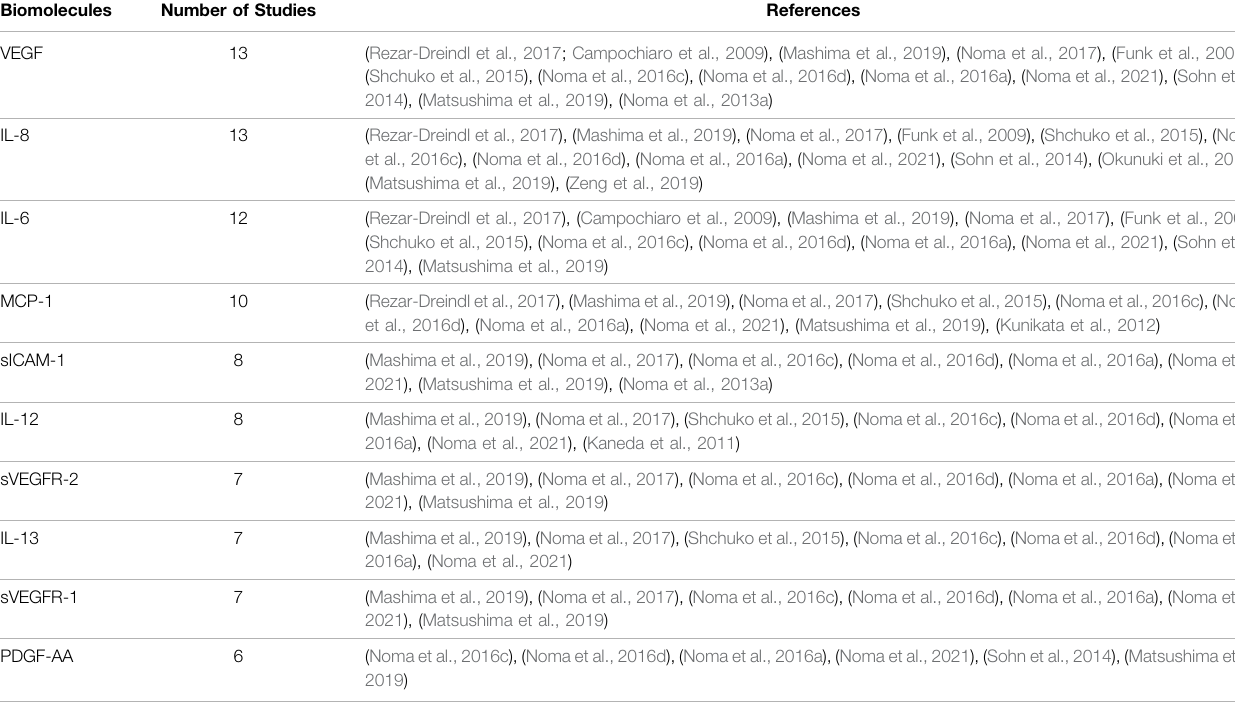
TABLE 2 | Studies pertaining to intraocular biomolecules and treatments in RVO a .